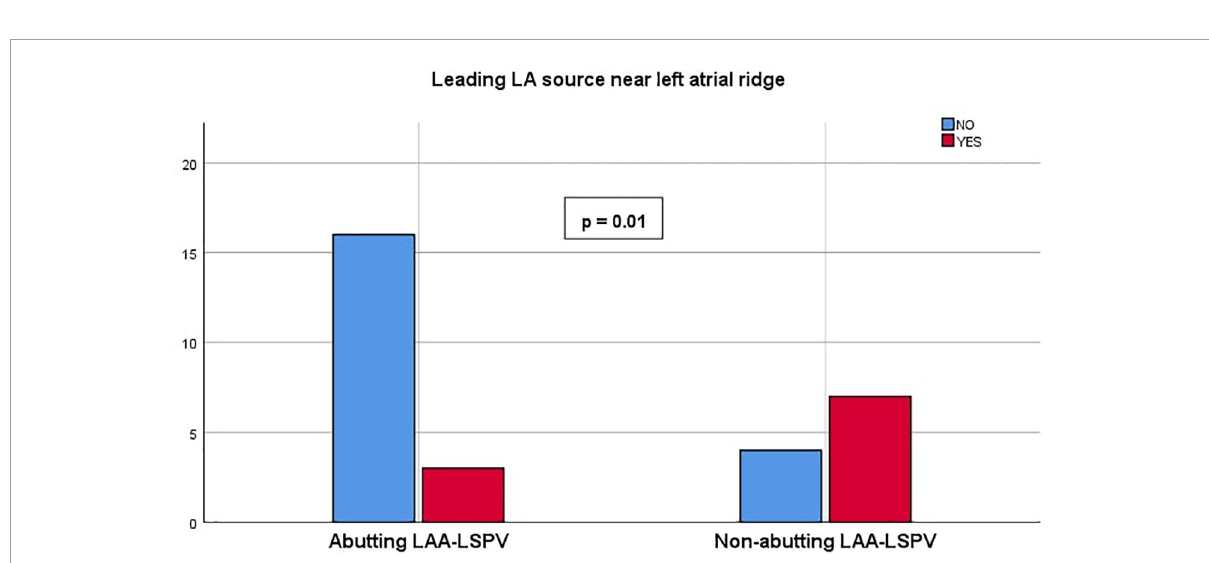
FIGURE2 Leading left atrium (LA) source near left atrial ridge. Chart representing the presence of leading source near left atrial ridge compared between abutting and non-abutting left atrial appendage–left superior pulmonary vein (LAA-LSPV) patient